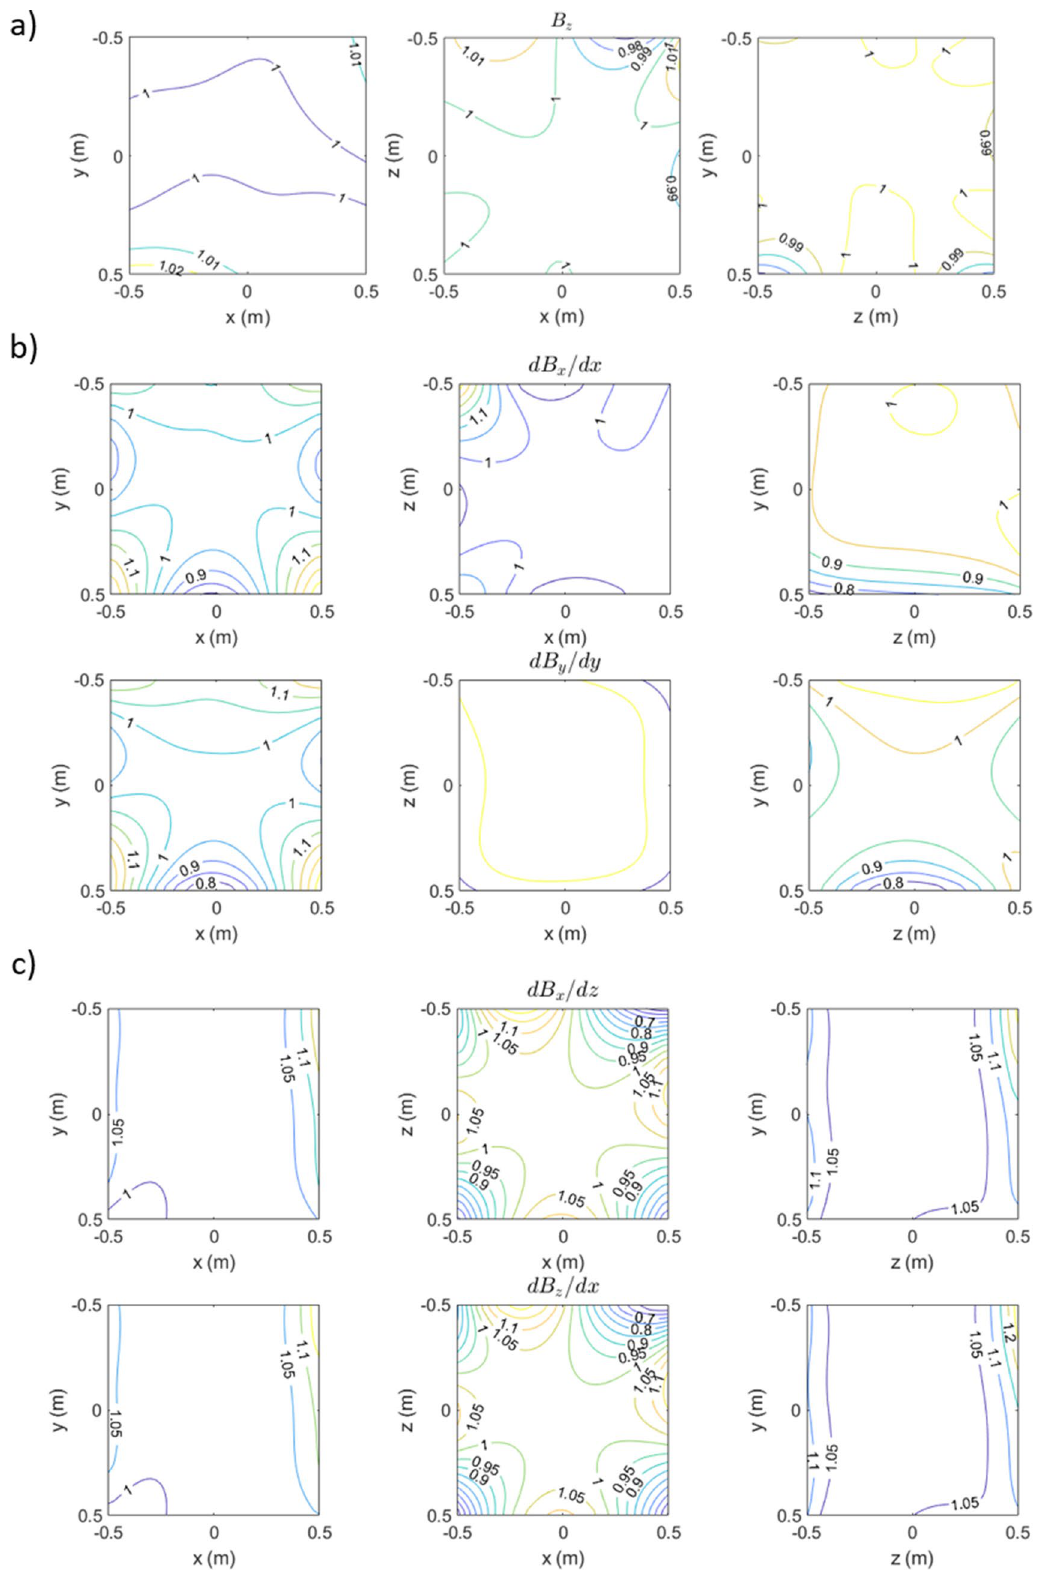
Figure 3. Simulated magnetic field components produced by the window coil active magnetic shielding system. Contours of the magnetic field variation for ( a ) a uniform magnetic field B z , ( b ) a longitudinal field gradient dB x / dx = − dB y / dy and ( c ) a transverse field gradient dB x / dz = dB z / dx . All contours are shown in three planes (arranged from left to right): z = 0 m |x|, |y|< 0.5 m, y = 0 m |x|, |z|< 0.5 m and x = 0 m |z|, |y|< 0.5 m respectively. The field values at each target point are normalised to the target field or field gradient strength (of 5 nT or 5 nT/m) to show deviation from uniformity. Contours of the remaining magnetic field components are shown in Online Appendix